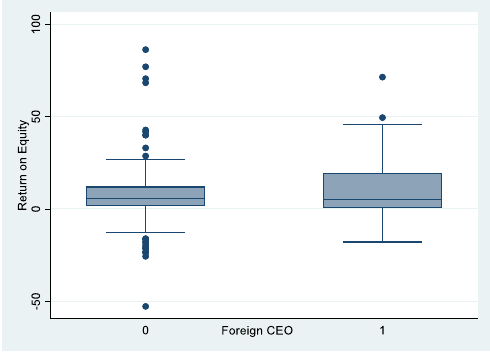
Figure 2. ROE and foreign CEO.